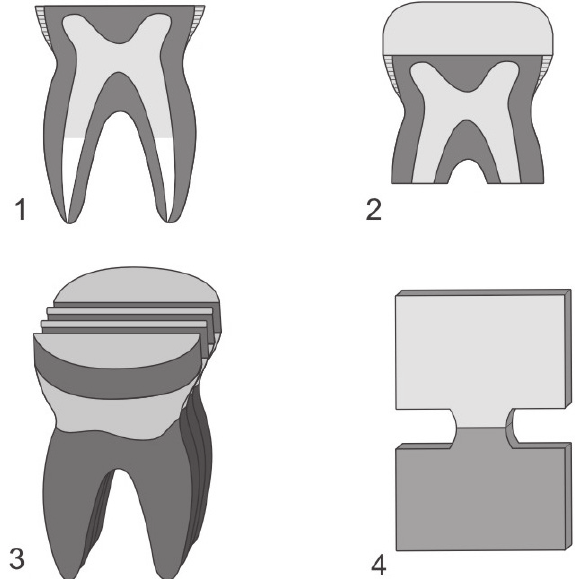
Figure 1- Schematic presentation of specimen preparation. (1) Exposed dentin, (2) Restored tooth, (3) Sectioning of the tooth to obtain four 1-mm-thick slabs from each tooth, (4) Hourglass-shaped